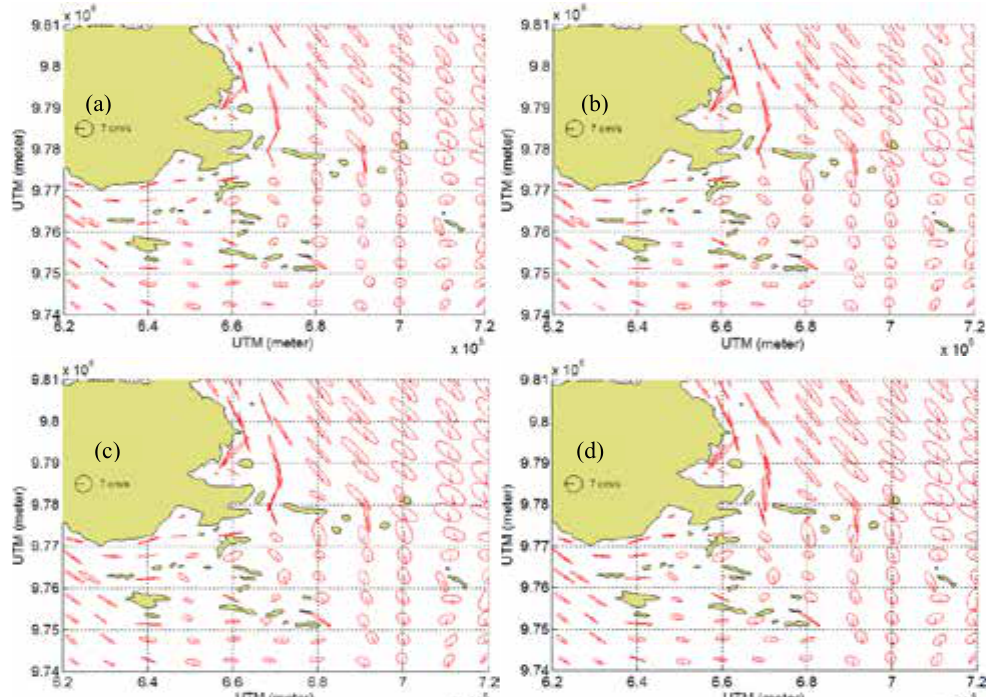
Fig. 10: The calculated S2 tidal current in layer-1 near bottom (a), layer-4 of water column (b), layer-7 of water column (c), and layer-10 at the surface water (d)